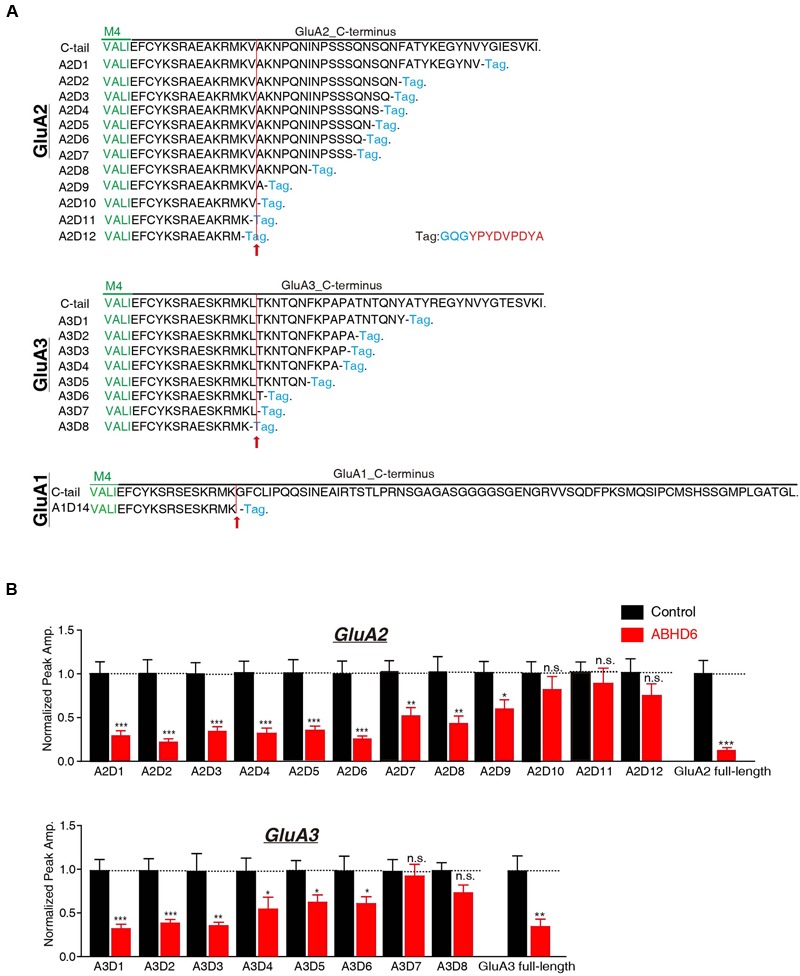
The C-terminus of GluAs mediated the inhibitory effect of ABHD6. (A) The amino acid sequences of different GluA1–3 deletion constructs. The arrow points to the mutants after which ABHD6 failed to reduce the amplitude of the glutamate-induced current. (B) Summary graphs of the peak amplitudes of 10 mM glutamate-induced currents in HEK293T cells transfected with different GluA2/GluA3 deletions, stargazin, and a control vector or vectors encoding ABHD6 (A2D1, control: 24/3, ABHD6: 24/3, p < 0.0001; A2D2, control: 26/3, ABHD6: 26/3, p < 0.0001; A2D3, control: 24/3, ABHD6: 24/3, p < 0.0001; A2D4, control: 24/3, ABHD6: 24/3, p < 0.0001; A2D5, control: 25/3, ABHD6: 24/3, p < 0.001; A2D6, control: 27/3, ABHD6: 27/3, p < 0.001; A2D7, control: 32/4, ABHD6: 32/4, p < 0.01; A2D8, control: 29/3, ABHD6: 29/3, p < 0.01; A2D9, control: 34/4, ABHD6: 34/4, p < 0.05; A2D10, control: 26/3, ABHD6: 26/3, p > 0.05; A2D11, control: 27/3, ABHD6: 27/3, p > 0.05; A2D12, control: 26/3, ABHD6: 26/3, p > 0.05; GluA2 full-length, 30/3, ABHD6: 30/3, p < 0.0001; A3D1, control: 24/3, ABHD6: 24/3, p < 0.0001; A3D2, control: 26/3, ABHD6: 26/3, p < 0.001; A3D3, control: 25/3, ABHD6: 25/3, p < 0.01; A3D4, control: 24/3, ABHD6: 24/3, p < 0.05; A3D5, control: 26/3, ABHD6: 26/3, p < 0.05; A3D6, control: 25/3, ABHD6: 25/3, p < 0.05; A3D7, control: 27/3, ABHD6: 27/3, p > 0.05; A3D8, control: 26/3, ABHD6: 26/3, p > 0.05; GluA3 full-length, 27/3, ABHD6: 27/3, p < 0.01). Each graph of the peak amplitude in HEK293T cells transfected with various ABHD6-expressing vectors was normalized to the peak amplitude in HEK293T cells transfected with the control vector. All summary graphs show means ± SEMs; statistical comparisons by Student’s t-test yielded: ∗p < 0.05, ∗∗p < 0.01, ∗∗∗p < 0.001.